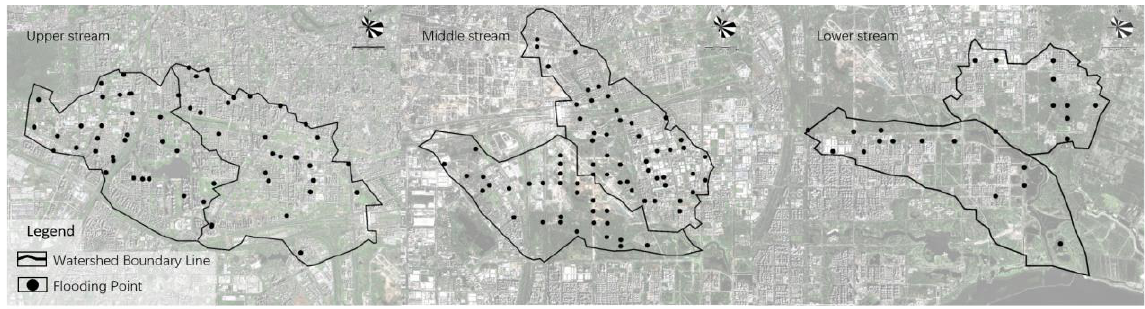
Figure 4. The distribution of overflow nodes with overflows exceeding 10 × 10 4 m 3 .